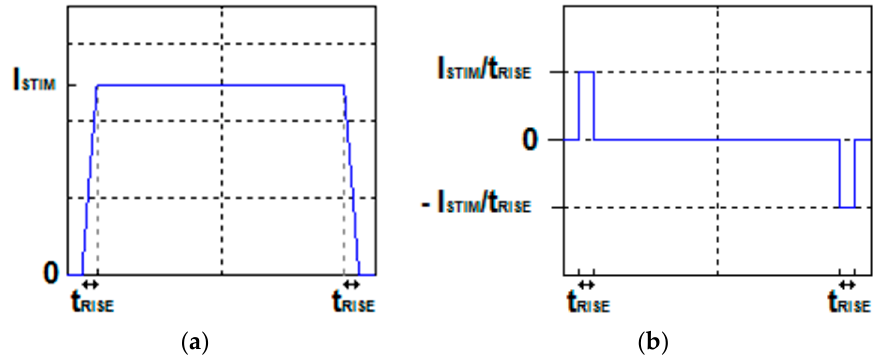
Figure 3. ( a ) Waveform of the stimulation current; ( b ) waveform of the derivative of the stimulation current.